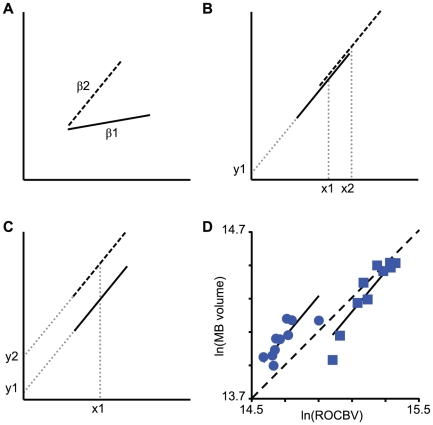
Examples of altered brain scaling relationships.Solid and dashed lines in (A–C) indicate hypothetical standardized major axis (SMA) scaling relationships of brain region volume (y variable) with brain size (x variable). (A) Altered slopes (β1 and β2), which preclude further scaling analyses using these methods. (A). Groups share a common scaling slope and y-intercept (y1) but average brain size differs between groups (×1 and ×2), producing an x-axis shift. (C) Groups share a common scaling slope and average brain size (×1) but y-intercepts (y1 and y2) are shifted, producing a grade shift. (D) Solid and dashed lines represent actual SMA scaling regressions of mushroom body volume versus remainder-of-central-brain volume (ROCBV) for mature P. pilifera minors (circles) and mature P. pilifera majors (squares), representative of a grade shift accompanying a shift along the x-axis. Dashed line in (d) indicates slope of 1 (isometry) for reference.